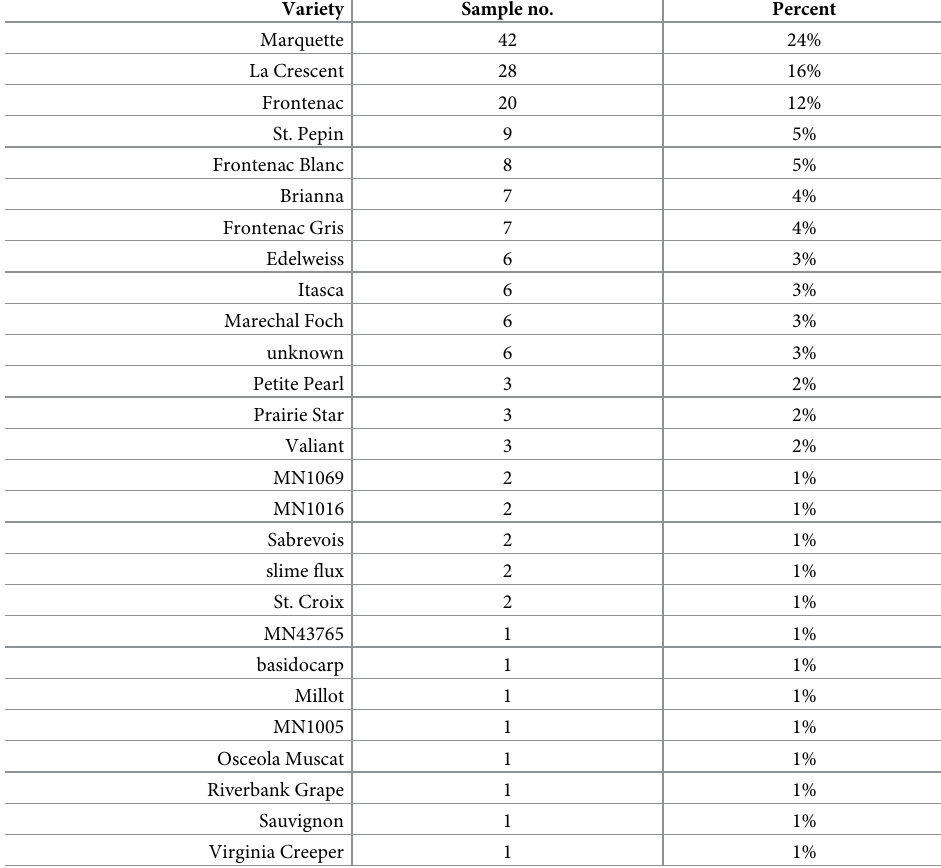
Table 2. Varieties of the 172 samples collected in the Northern Midwest in